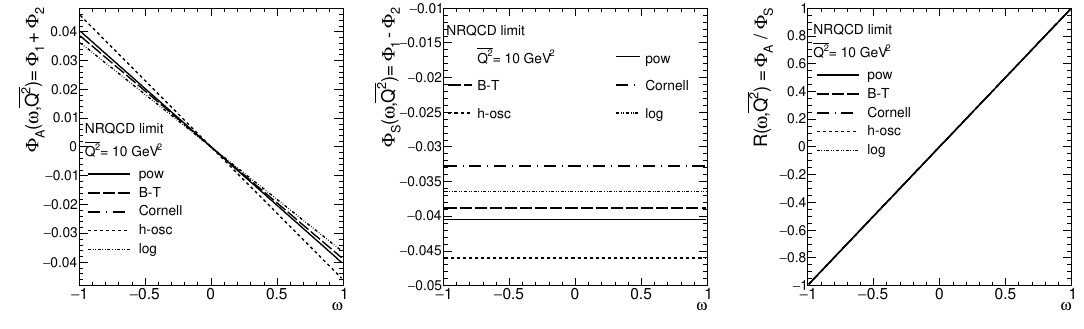
Figure 2 . Antisymmetric Φ A and symmetric Φ S form factors in the nonrelativistic limit with the specific value of the quark mass m c and the first derivative R 0 (0) depending on each potential model, see table